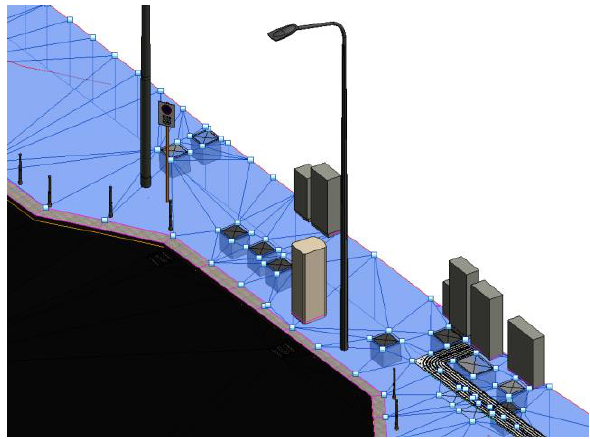
Figure 4. In evidence, the component slab with anchorage points used to create the paved